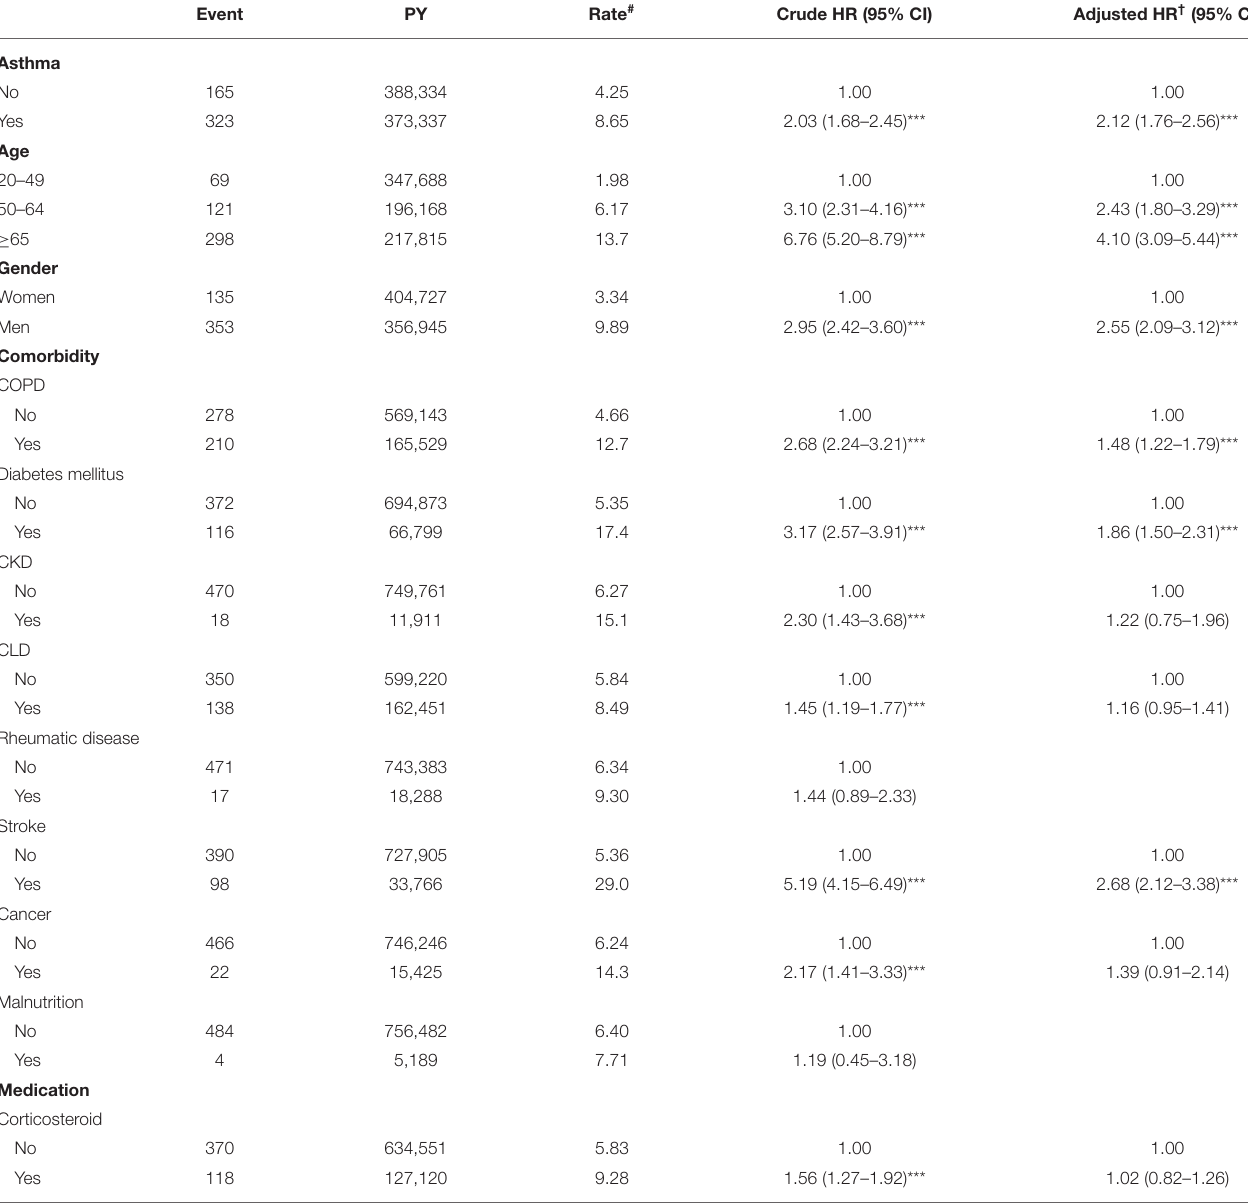
TABLE 2 | Incidences and hazard ratios of pleural empyema by asthma, age, gender, comorbidity, and corticosteroid use among all